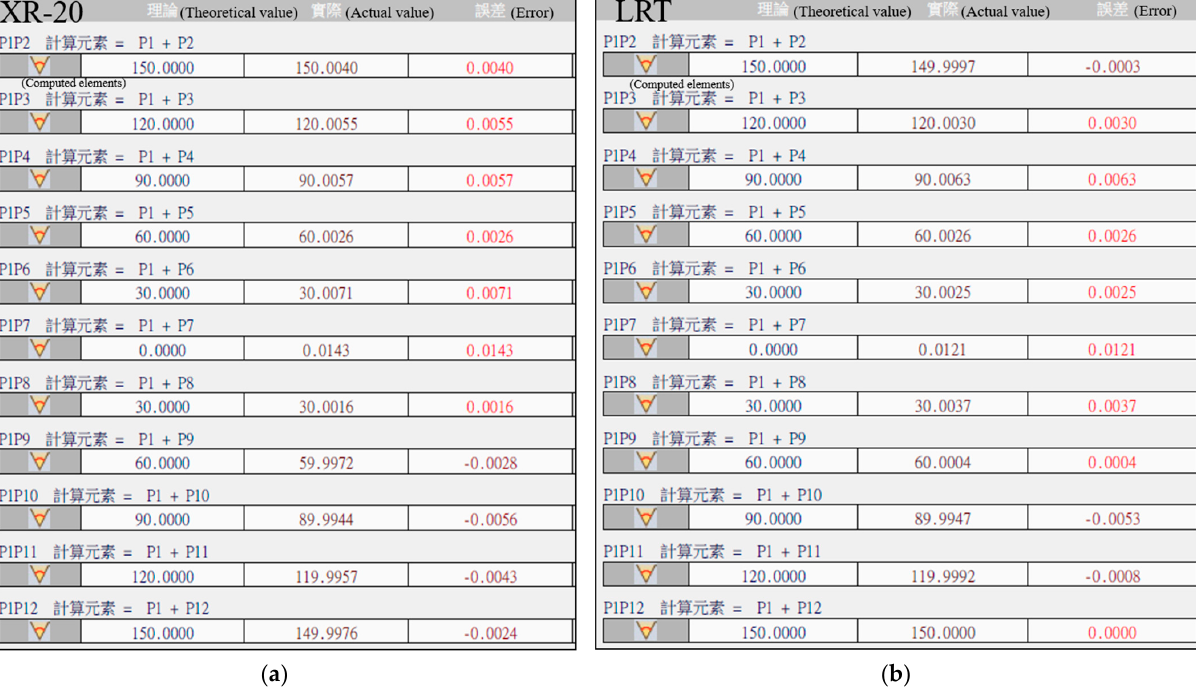
( b ) Figure 29. The measured result from CMM ABLE-686-CNC: ( a ) results from the workpiece using XR-20W; and( b ) results from the workpiece using Laser R-test.